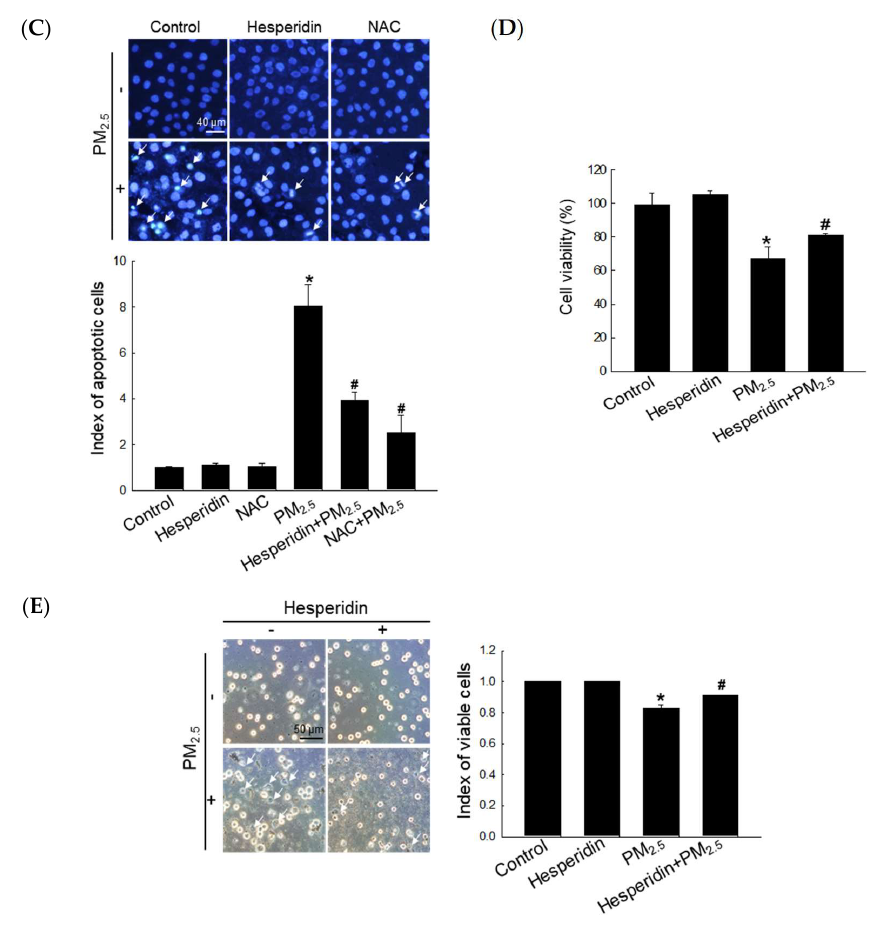
Figure 1. Hesperidin alleviated intracellular ROS generation and cell viability reduction. Cells were pretreated with hesperidin (50 µM) or NAC (1 mM) for 1 h, and then exposed to PM 2.5 (50 µg/mL) for another 24 h. Intracellular ROS generation was observed using ( A ) flow cytometry and ( B ) confocal microscopy after H 2 DCFDA staining. ( C ) Apoptotic body formation was detected via Hoechst 33342 staining. Arrow indicates apoptotic body. ( D ) MTT and ( E ) trypan blue assays were used to determine cell viability. Arrows indicate the dead cells. * p < 0.05 and # p < 0.05 compared with the control cells and PM 2.5 -treated cells, respectively.